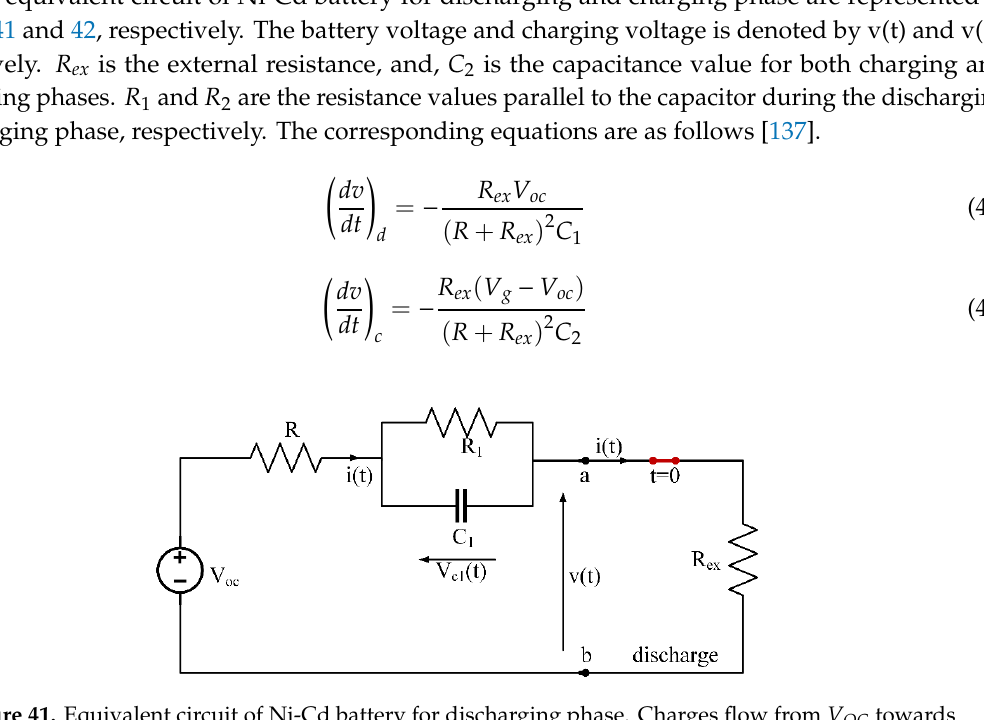
Figure 41. Equivalent circuit of Ni-Cd battery for discharging phase. Charges flow from V OC towards the external resistance R ex [137].